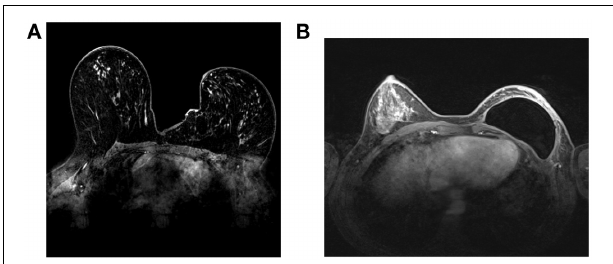
FIGURE 3 | Breast MRI images at 1.5T. A conventional breast MRI image (without contrast agent) (A) . A breast prosthesis can be seen in the right breast (B)